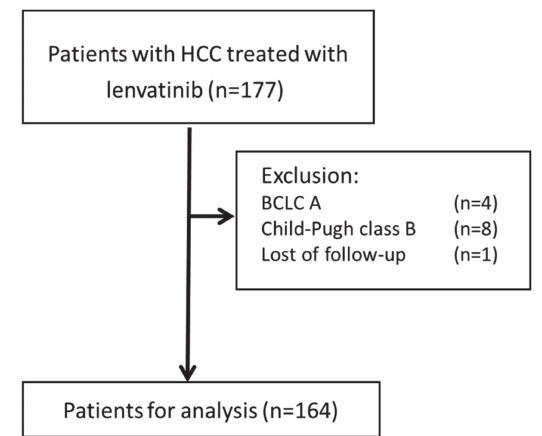
Figure A1. Study design. A total of 177 patients with HCC were enrolled between 24 March 2018 and 28 February 2019. In the course of the study, 13 patients were excluded, and 164 patients with HCC were included in the analysis. Abbreviations: HCC, hepatocellular carcinoma; BCLC, Barcelona Clinic Liver